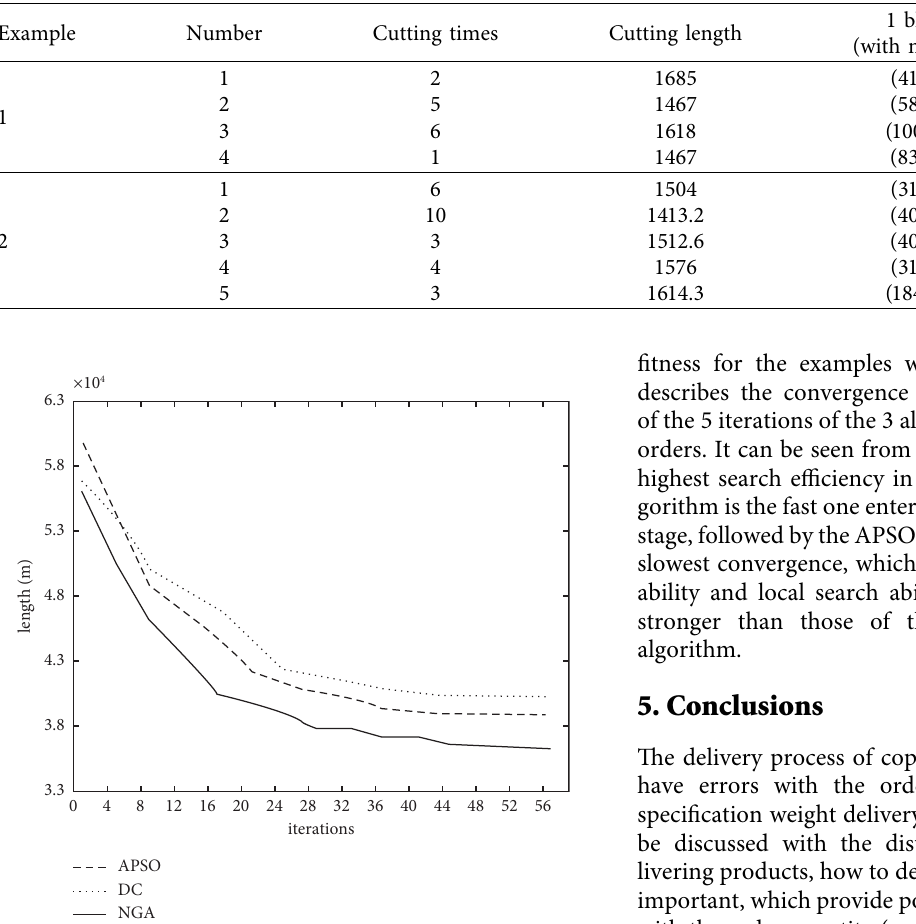
Figure 4: Convergence curves of three